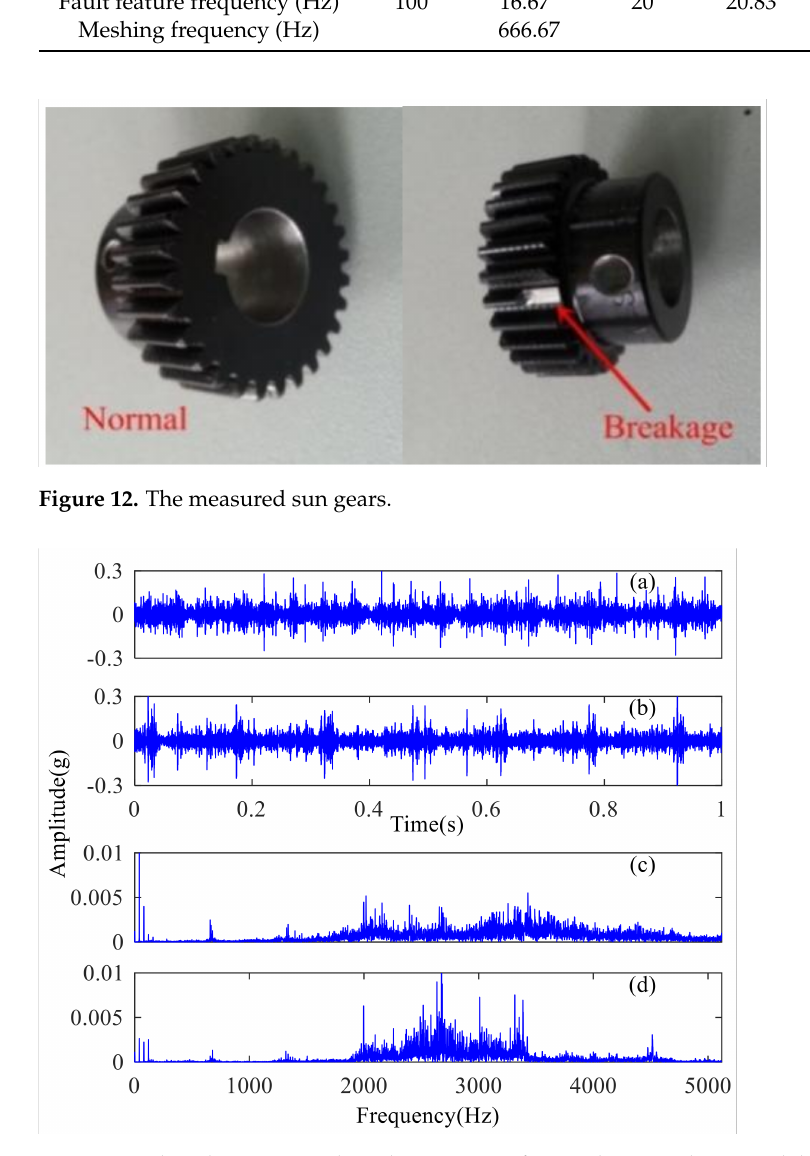
Figure 13. The vibration signals and spectrums of normal gear and gear with breakage: ( a ) vibration signal of normal gear, ( b ) vibration signal of gear with breakage, ( c ) frequency spectrum of normal gear, and ( d ) frequency spectrum of gear with